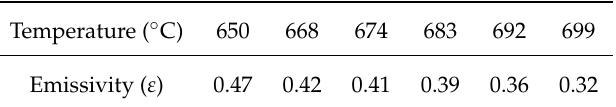
Table 1. Experimental data for the emissivity values at different temperatures of lightly oxidized Al, based on the above-mentioned conditions.